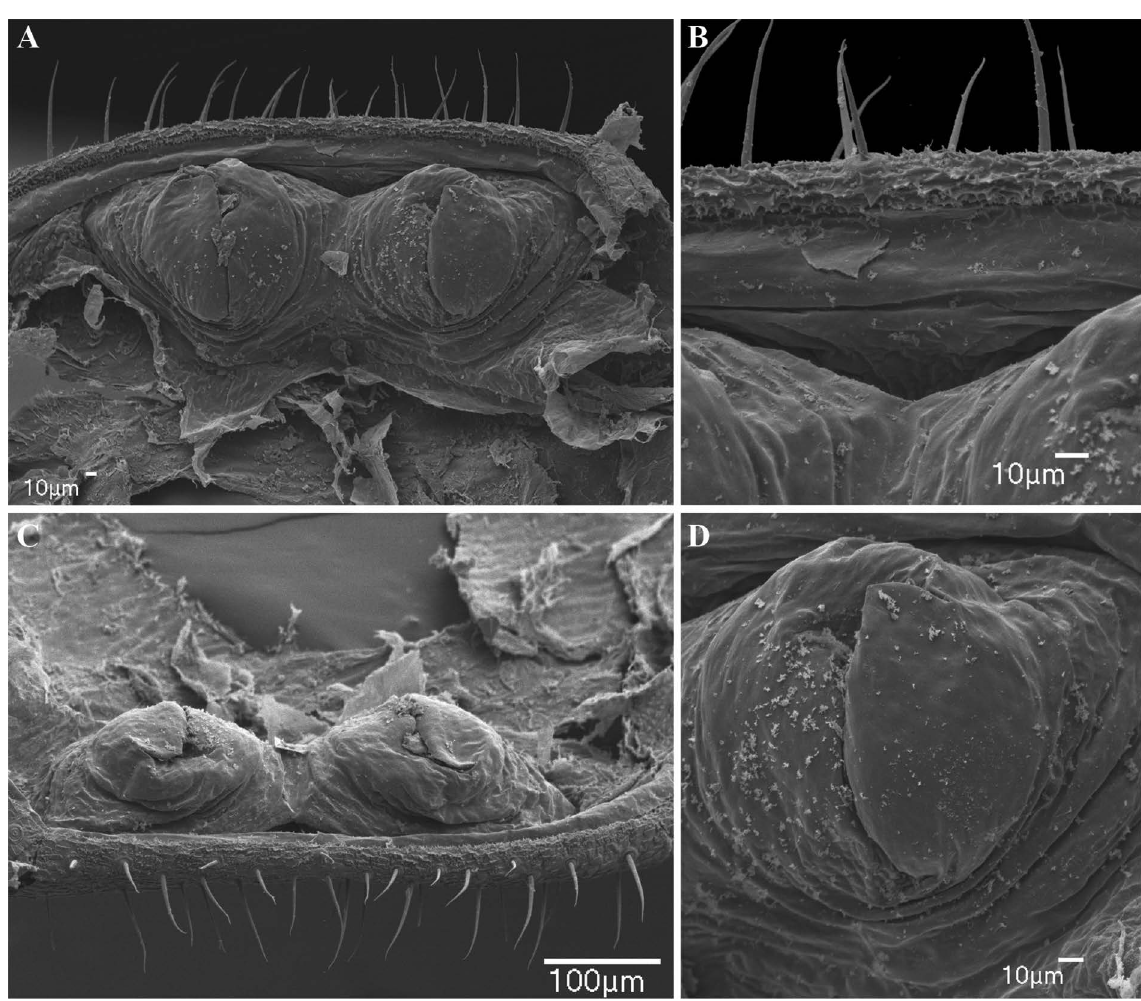
Fig. 17. Charinus caribensis (Quintero, 1986) (SMNS), female gonopod. A . Gonopod, ventral view. B . Genital operculum between gonopods. C . Gonopod, posterior view. D .